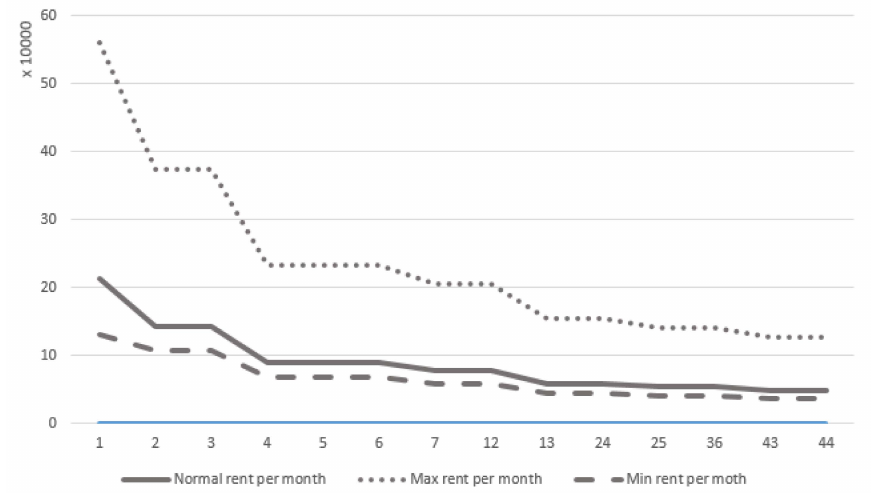
Figure 8. The result of applying risk factors to the rental